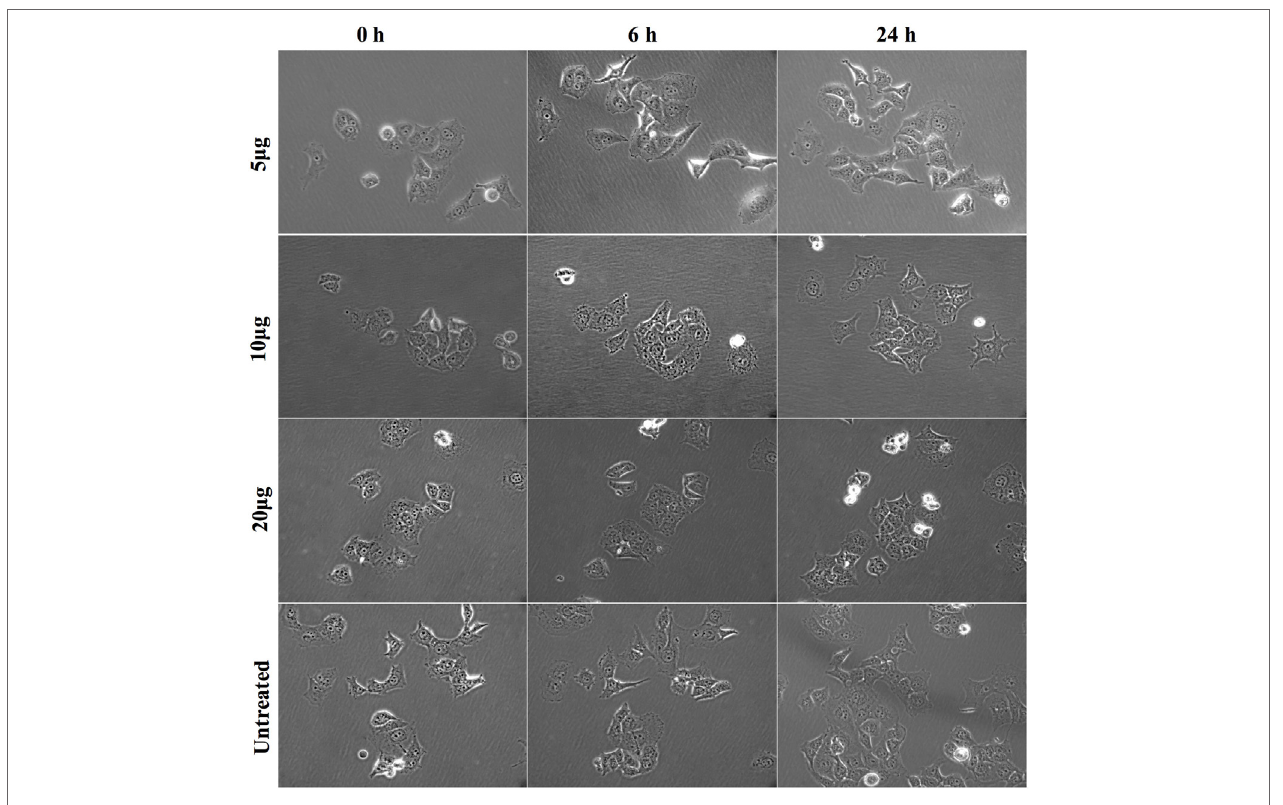
FigUre 3 | Morphological changes in Panc-1 cells following rfhSP-D treatment. Panc-1 cells (0.1 × 10 4 ) were grown overnight in a 12-well plate tissue culture and colonies of 5–10 cells were selected for analysis with and without rfhSP-D (5, 10, and 20 µg/ml) at 0, 6, and 24 h. The cells treated with 5 µg/ml and untreated appeared to undergo epithelial-to-mesenchymal transition as they acquired spindle shape and showed reduced cell–cell contact, whereas cells treated with 10 and 20 µg/ml appeared static and did not acquire spindle